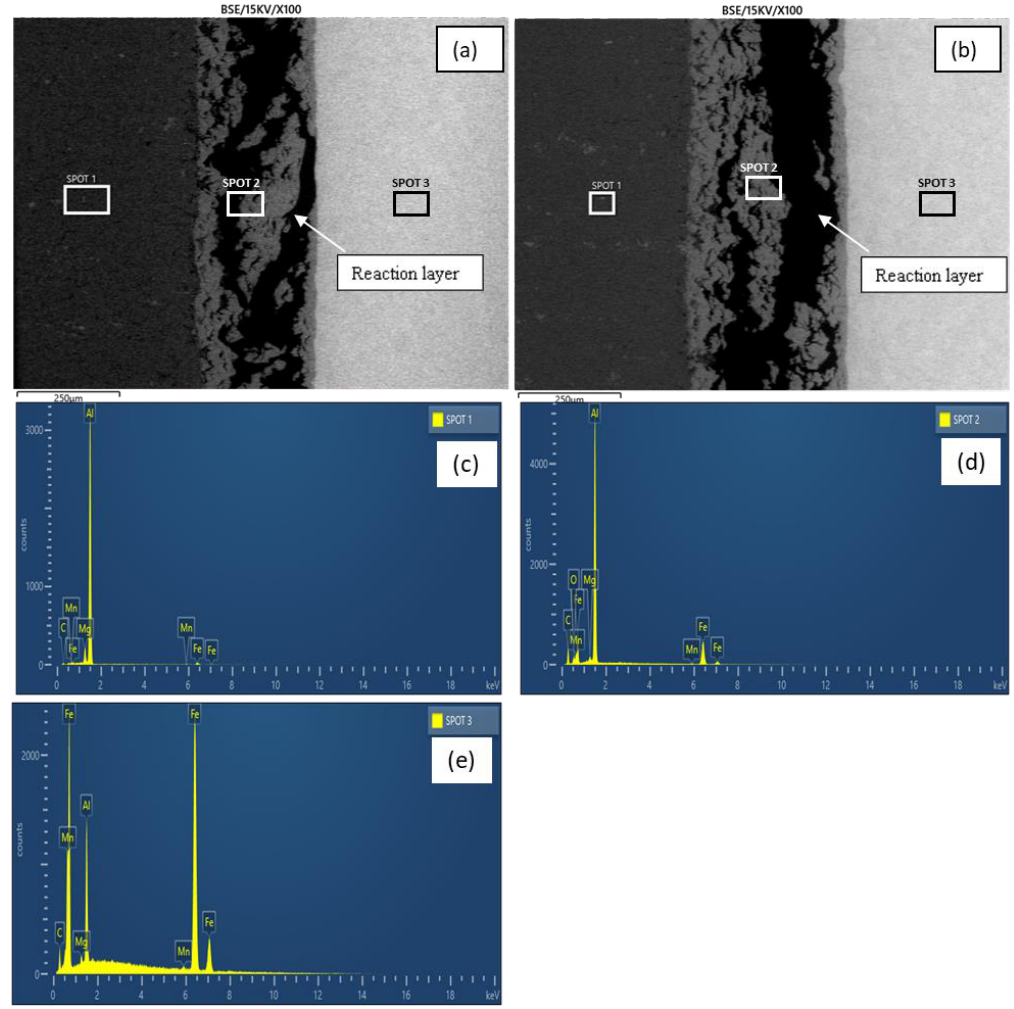
Figure 9. ( a ) Micrograph of sample E; ( b ) Micrograph of sample G; ( c ) Sample G EDX analysis (spot 1); ( d ) Sample G EDX analysis (spot 2); ( e ) Sample G EDX analysis (spot 3).